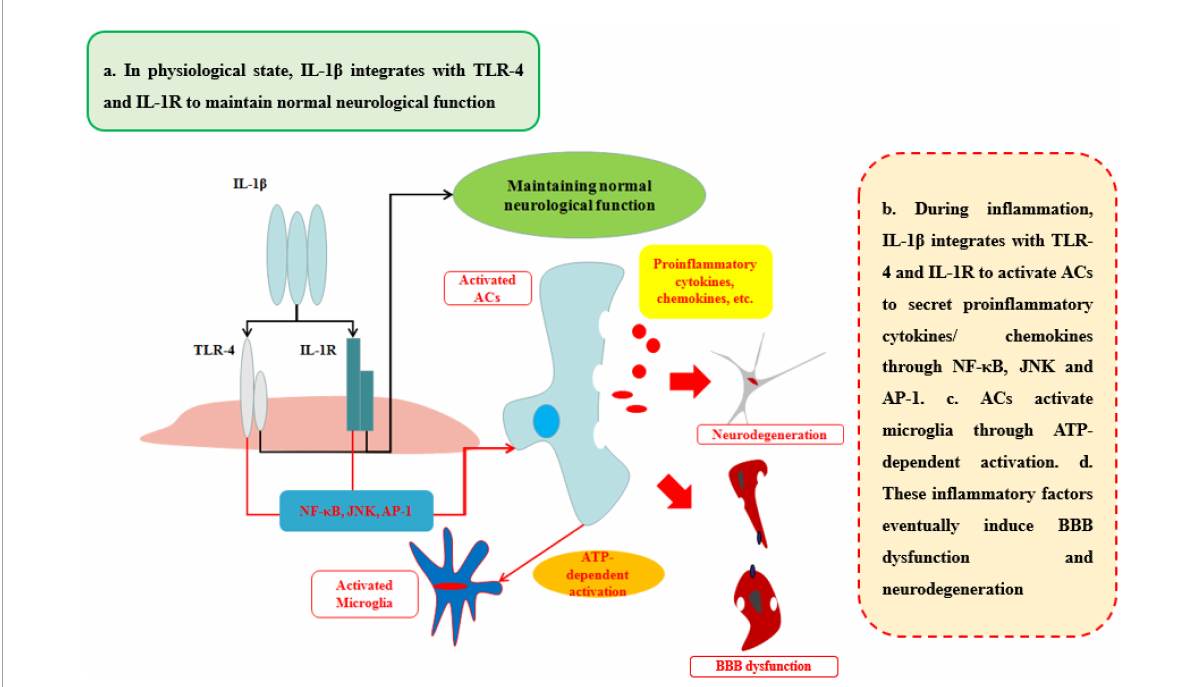
FIGURE4 Effects of IL-1 β on BBB and neurological degeneration. In healthy status, IL-1 β integrates with TLR-4 and IL-1R to maintain normal neurological function in CNS. During inflammation, IL-1 β integrates with TLR-4 and IL-1R to activate ACs to secrete pro-inflammatory cytokines